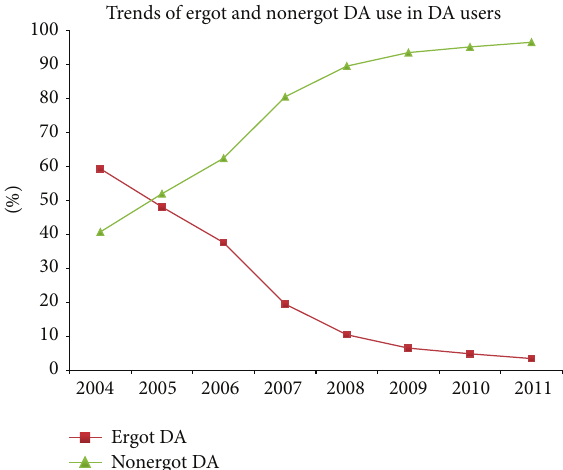
Figure 3: Time trends for ergot and nonergot DA prescriptions among DA users from 2004 to 2011. DA: dopamine